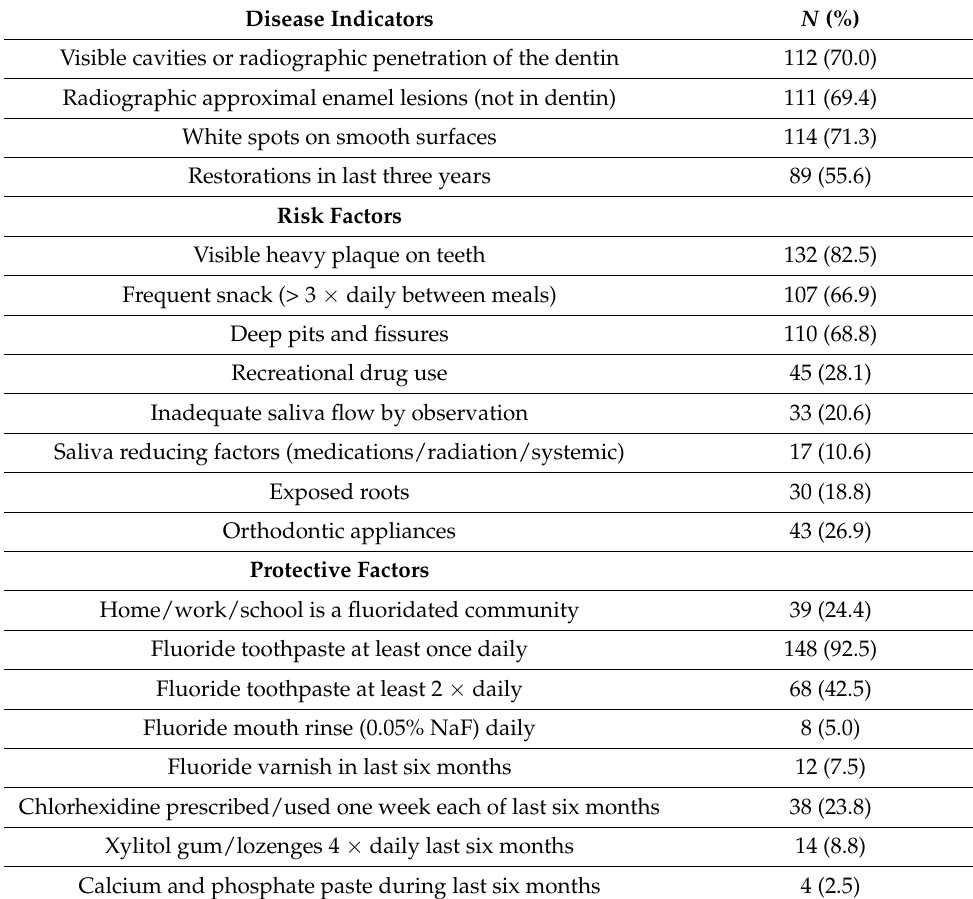
Table 2. Distribution of study participants according to disease indicators, risk, and protective factors.